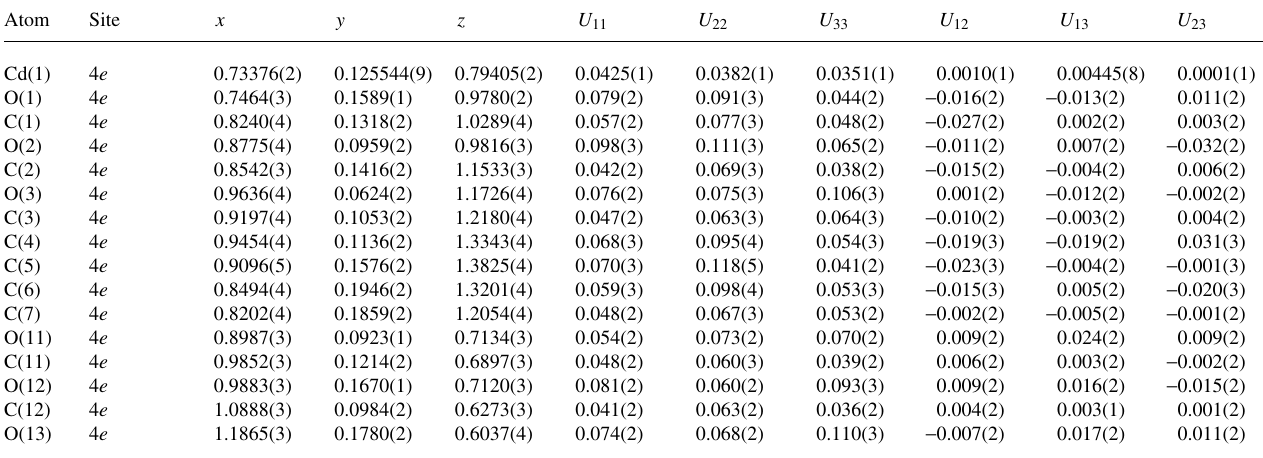
Table 3. Atomic coordinates and displacement parameters (in Å 2 ) .